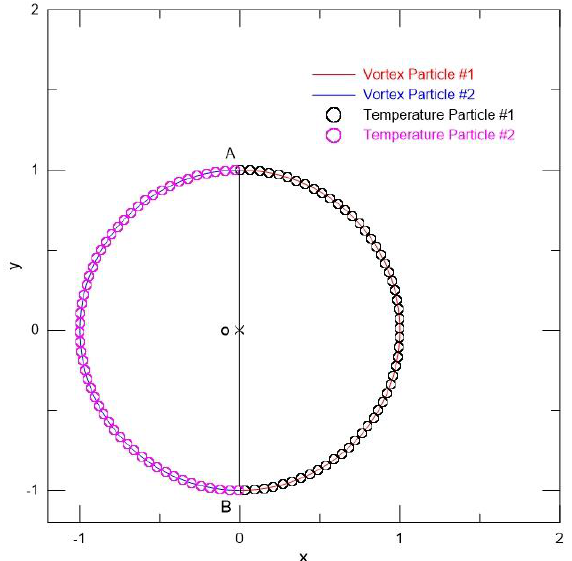
Figure 3. Numerical estimate of advective motion by the second-order Adams – Bashforth time marching scheme ( ∆ t = 0.05).